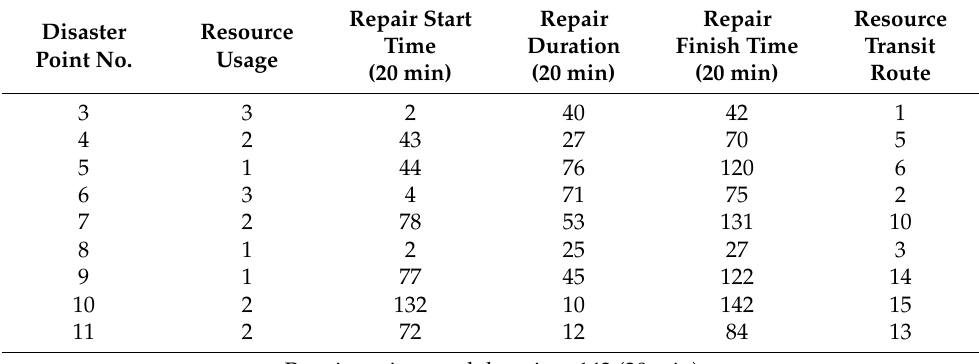
Figure 7. Diagram of the repair process after new disaster point occurs (Case 2). Table 11. Rescheduling results after new disaster point